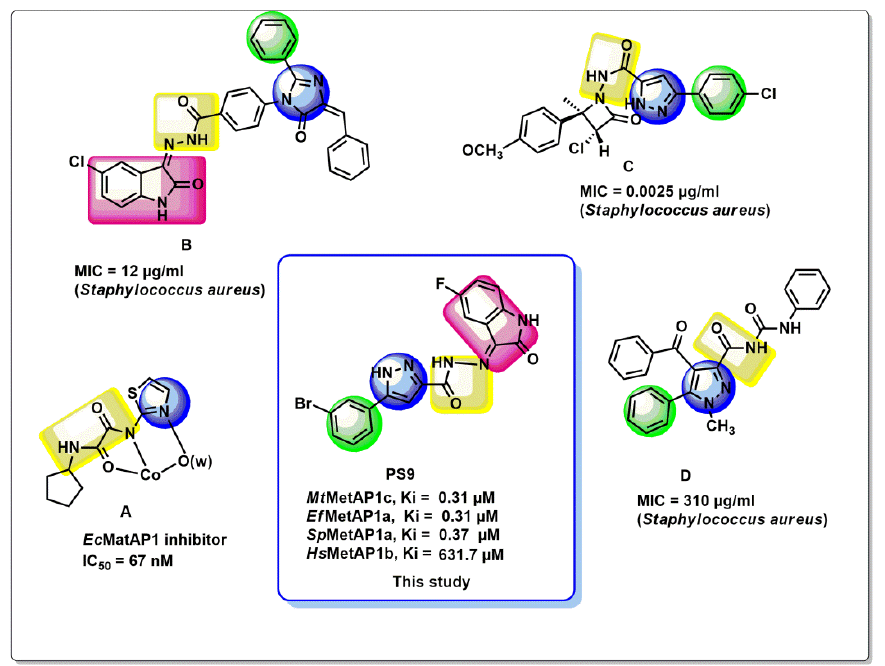
Figure 1. The rationale for the design and synthesis of pyrazole linked Isatin hydrazone conjugates as antibacterial agents.